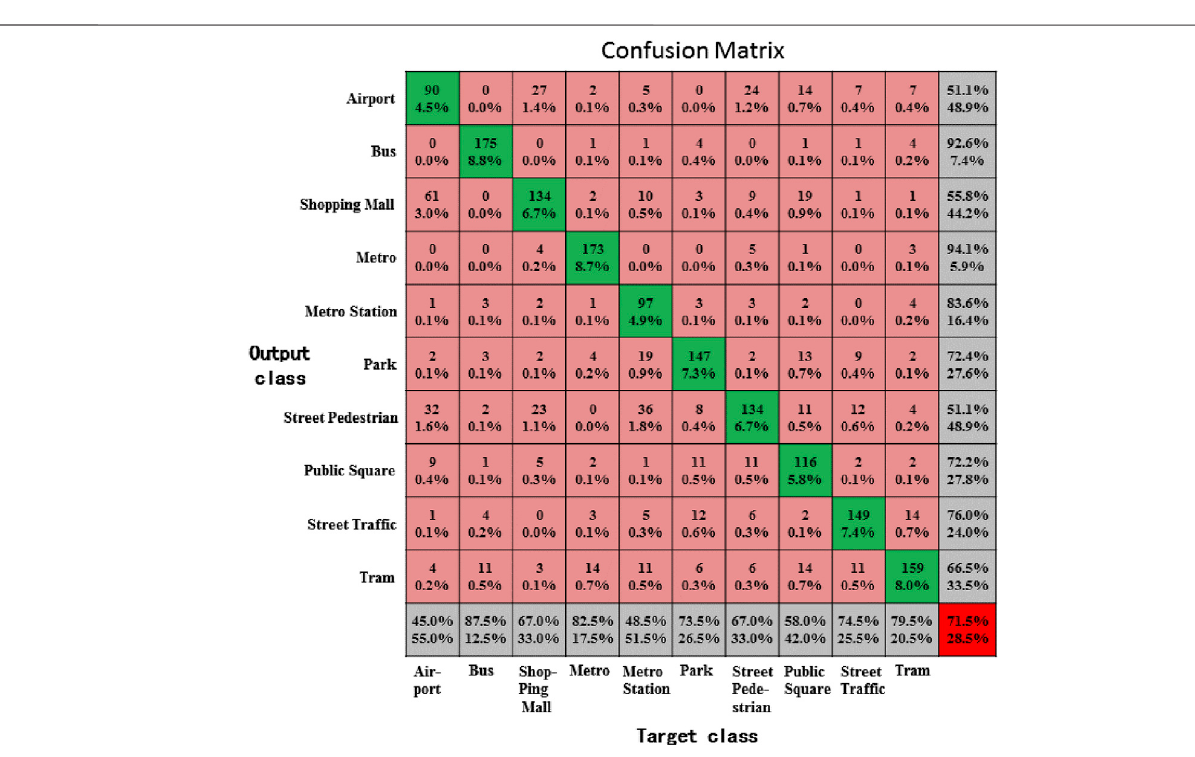
Frontiers in Physics |